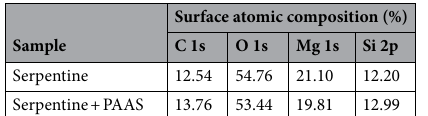
Table 4. Relative contents of elements on the serpentine surface.